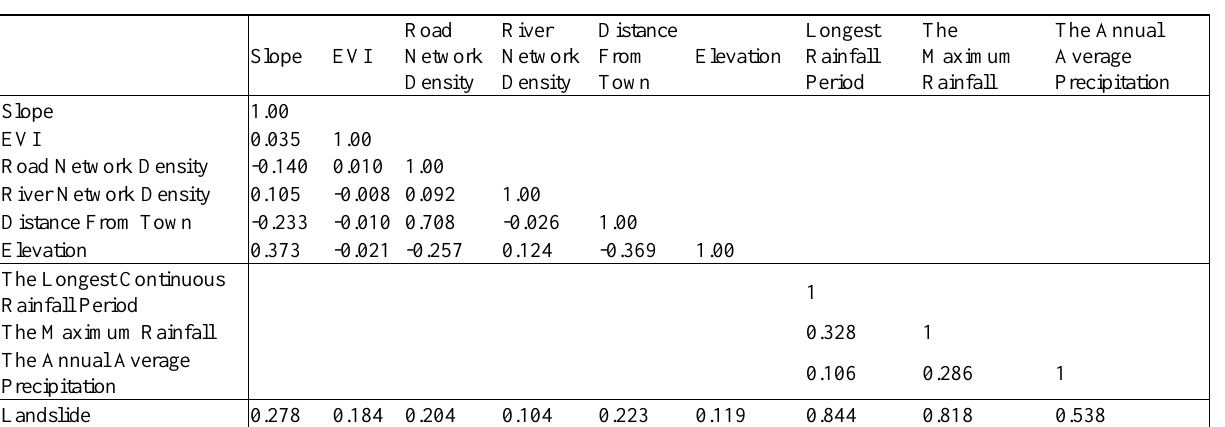
Table 2. Correlation coefficient calculation result table